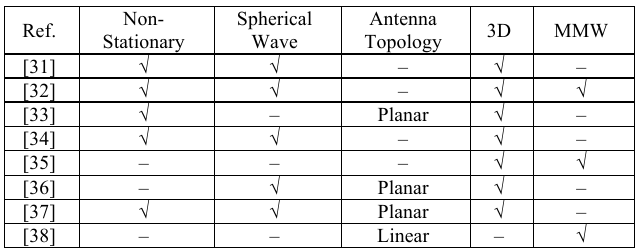
TABLE I. C HARACTERISTICS OF SOME M-MIMO CHANNEL MODELS .